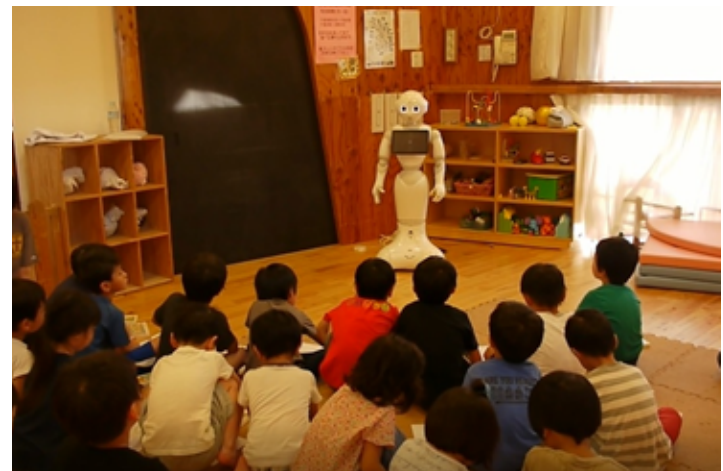
Figure 3. Japanese participants.